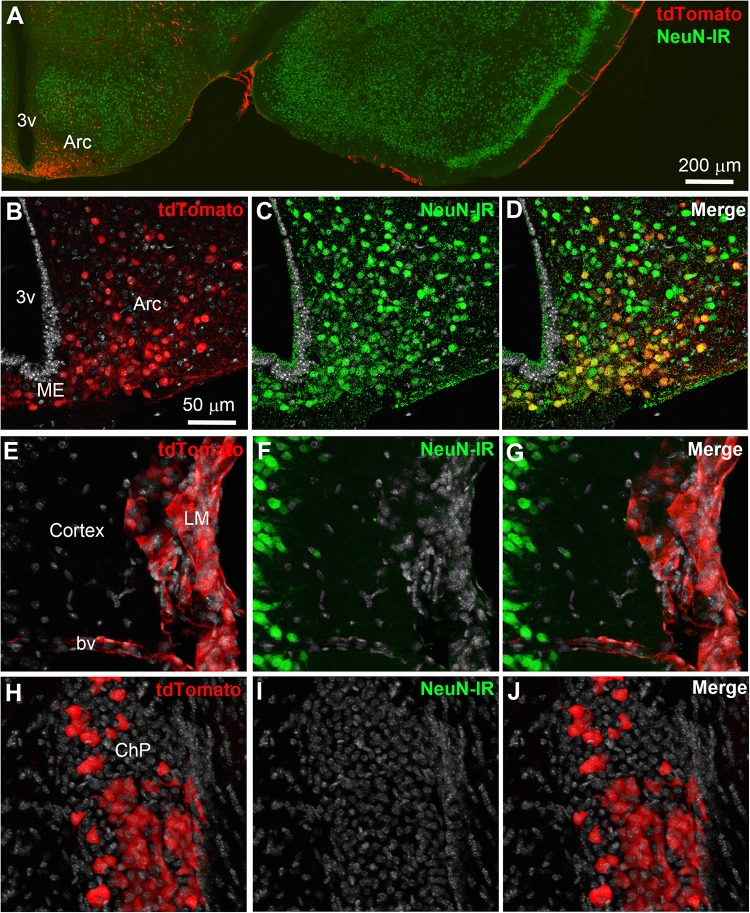
Distribution of NeuN immunoreactivity relative to tdTomato-labeled cells. (A–D) Distribution of nuclear NeuN immunoreactivity (green) in the mediobasal hypothalamus of LepRb-Cre-tdTomato mice. Immunoreactivity was present of all tdTomato-labeled cells in the parenchyma including the arcuate nucleus of the hypothalamus. (E–G) Fluorescence for tdTomato was seen in area completely devoid of neurons such as the leptomeninges and around scattered blood vessels. (H–J) The choroid plexus also contained many epithelial TdTomato-labeled cells. DAPI was converted to gray. Scale bar in (B) applies through (J). Arc, arcuate nucleus; bv, blood vessel; ChP, choroid plexus; LM, leptomeninges; ME, median eminence.